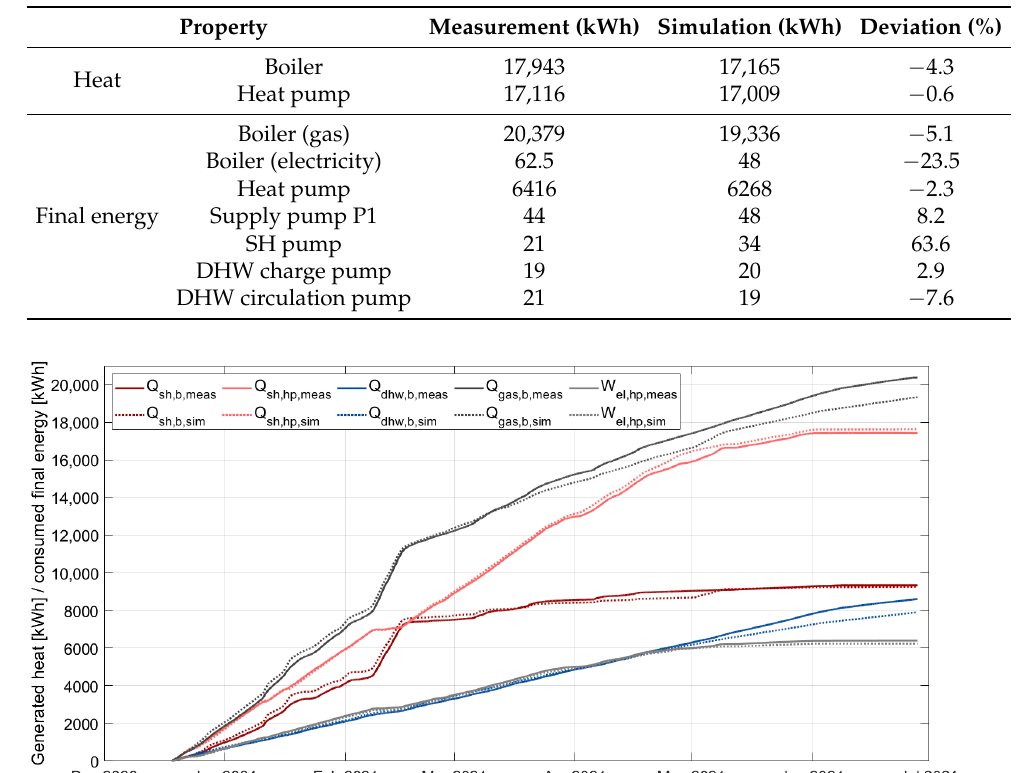
Table 5. Provided and used energy with respective deviation in measurement and simulation.